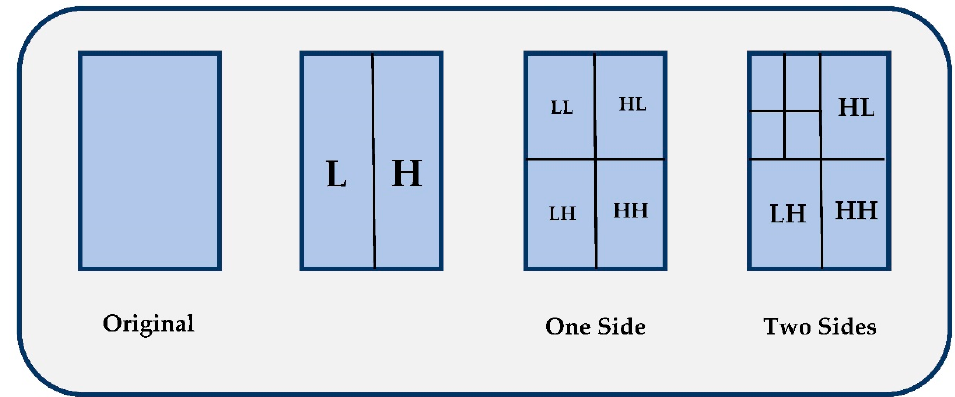
Figure 3. Decomposition of an image using DWT.